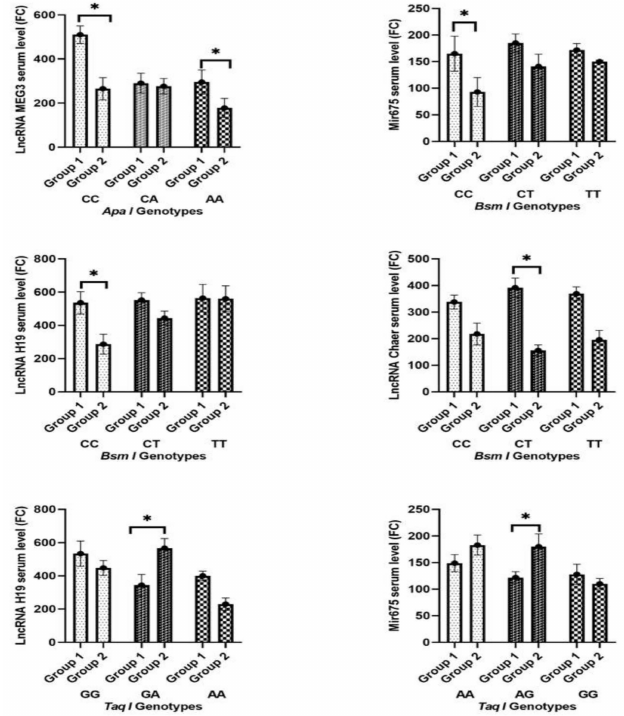
Figure 3. Change in cardiac biomarkers and non-coding RNA levels in both groups among different genotypes. * Significant difference ( p <